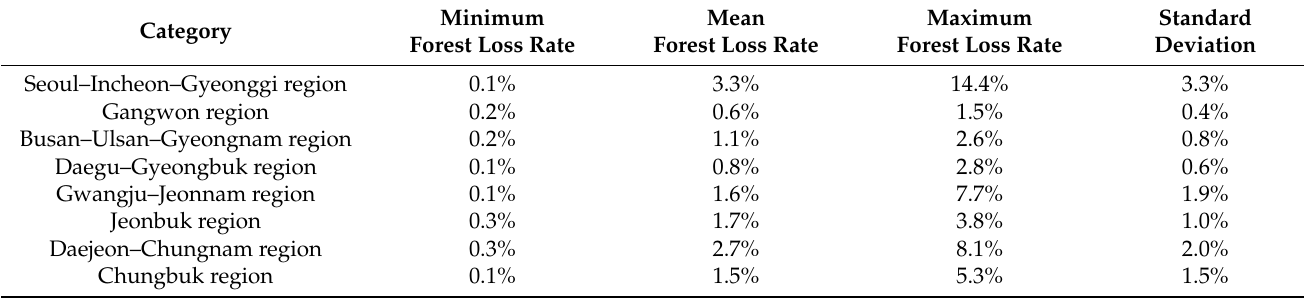
Table 5. Distribution of forest loss rate across spatial